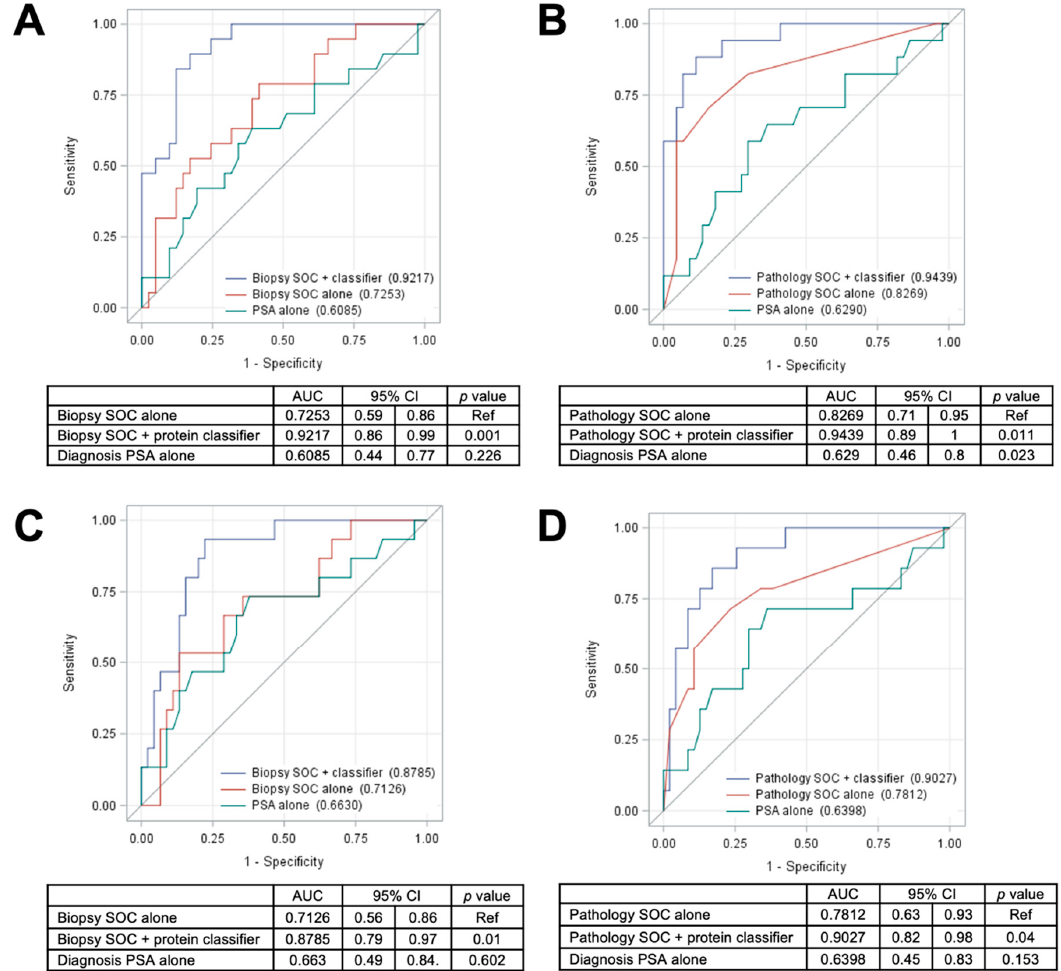
Figure 4. ROC curves predicting DM and BCR using SOC base models with versus without the protein classifier in the testing cohort: ROC curve analyses for DM with comparison of AUC values for biopsy and pathology SOC base models alone versus in combination with the 5-protein classifier are shown in ( A ) and ( B ), respectively. Similar analyses for BCR are shown in ( C ) and ( D ), respectively. The ROC curve analysis results using serum PSA alone were also shown as reference.